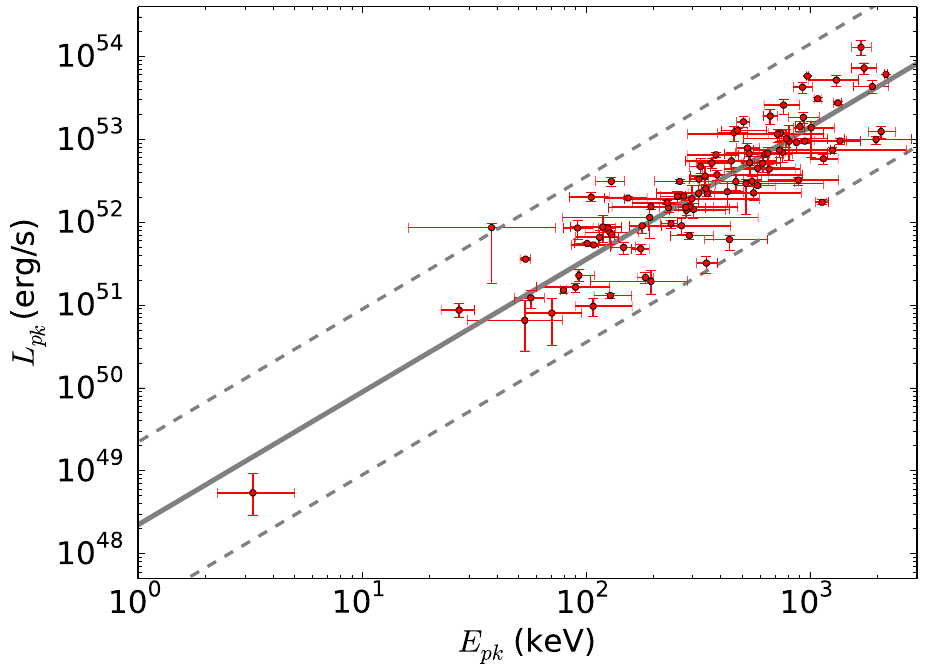
Figure 4. The E pk - L pk diagram of LGRBs taken from Yonetoku et al. [112]. The solid and dashed lines show the best fit function and the 3 σ systematic errors of the Yonetoku relation, respectively. Data from Yonetoku et al.